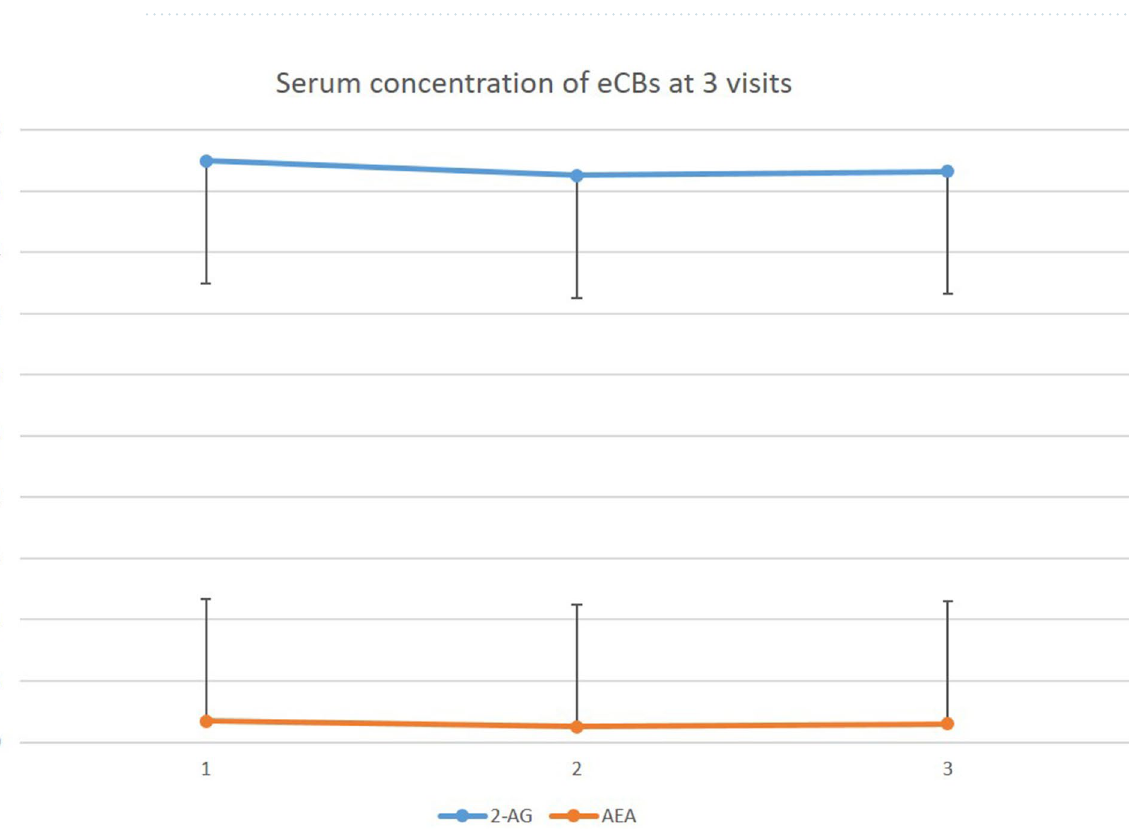
Table 1. Phenotypic mean scores and serum eCB levels of symptom scales at different visit timepoints. Means and standard deviations (SD) are presented. BDI Beck Depression Inventory, MADRS Montgomery- Asberg Depression Scale, BAI Beck Anxiety Inventory, SHAPS Snaith–Hamilton Pleasure Scale, ISI Insomnia Severity Index, TMT Trail Making Test, SCWT Stroop Colour-Word Test, 2-AG 2-arachidonoylglycerol, AEA anandamide. a Paired sample t test.